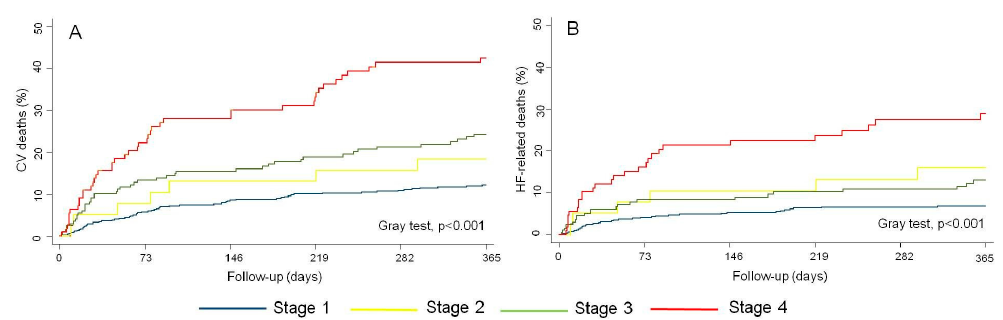
Figure5. ( A )Cumulativeeventratesofcardiovascularmortalityriskacrossrightventriculardysfunction Figure 5. (A) Cumulative event rates of cardiovascular mortality risk across right ventricular stages. ( B ) Cumulative event rates of heart failure-related mortality across right ventricular dysfunction dysfunction stages. (B) Cumulative event rates of heart failure-related mortality across right stages. CV: cardiovascular; HF: heart ventricular dysfunction stages. CV: cardiovascular; HF: heart failure.